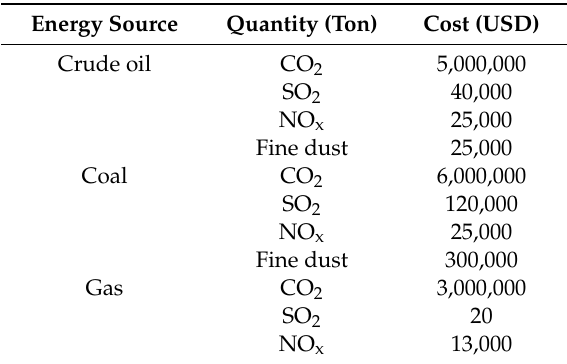
Table 2. Pollutant generation and cost from various generation plants for 1 GW / year